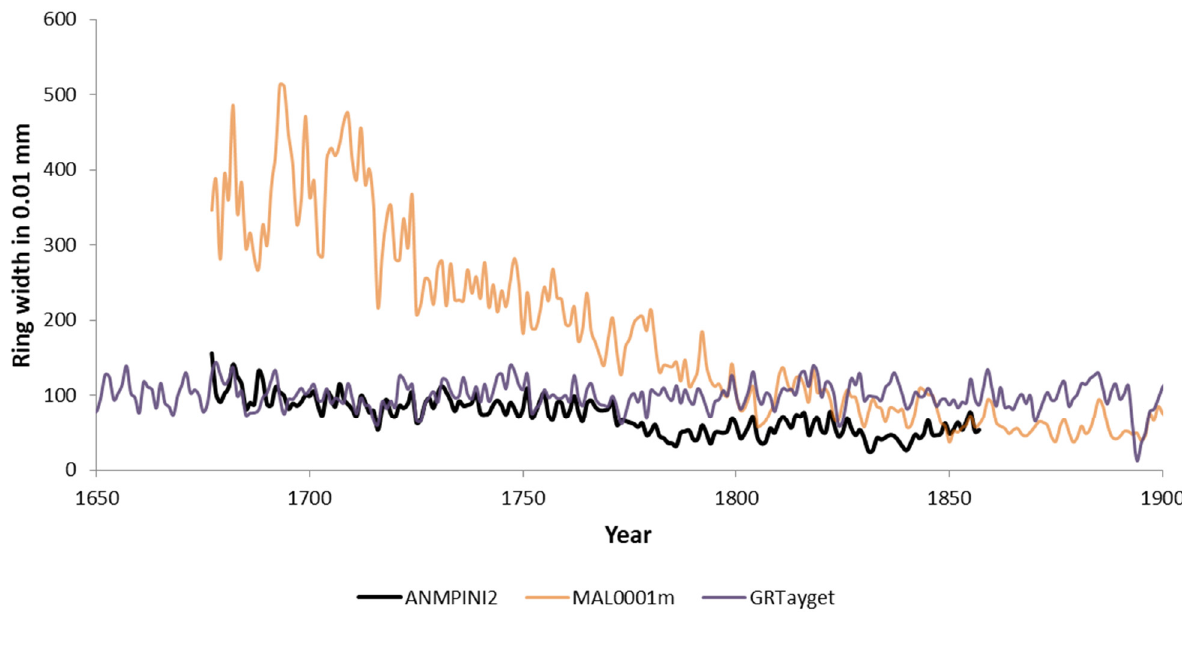
Figure 7. Visual cross-matching of the newly developed mean chronologies (in black) and the reference chronologies with different colors. Only the overlapping period of the reference chronologies is presented. ( a ) Bosnian pine chronology (ANMPIHE) with Bosnian pine chronology from the study area (MAVRO01m) and Grevena (GrGreven) [53]; ( b ) Black pine chronology (ANMPINI1) with Bosnian pine chronology from the study area (MAVRO01m) and Mt Smolikas (EHS01_Smolikas) [35]; ( c ) Black pine chronology (ANMPINI2) with Black pine chronology from the study area (MAL0001m) and Mt Taygetos (GRTayget) [56]. Table 3. Mean chronologies developed for the two pine species from historical timber from the Monastery of St. Nicholas. Table 4. Cross-dating results of the three developed pine chronologies (PIHE for Pinus heldreichii and PINI for Pinus nigra ) against the reference chronologies providing the best results. t-value Baillie-Pilcher (TVBP) and t-value Hollstein (TVH) are t-values sensitive to extreme values, such as marker years. CDI = cross-dating index; Glk = Gleichlaeufigkeit, a measure of how well the growth of two trees corresponds to each other in an overlapping set of